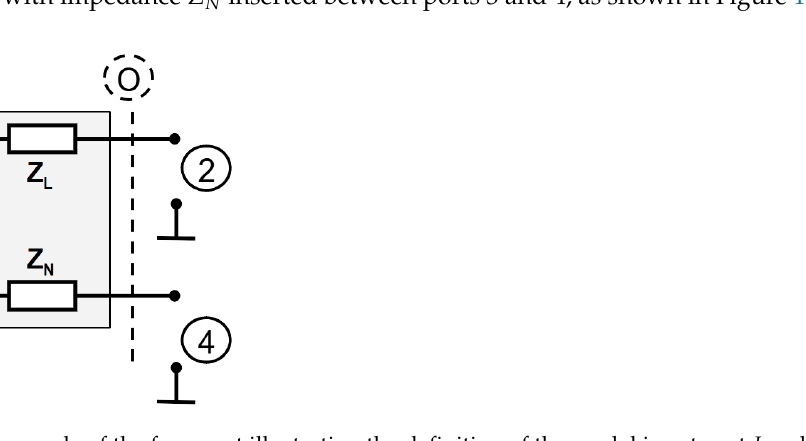
Figure 1. An example of the four-port illustrating the definition of the modal input port I and the modal output O